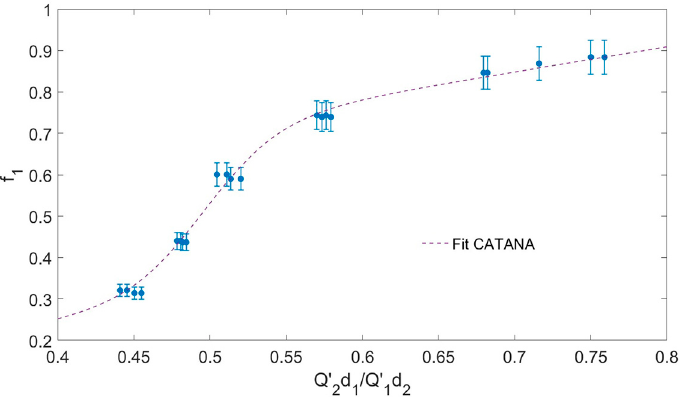
(cid:48) d 1 /Q (cid:48) d 2 2 1